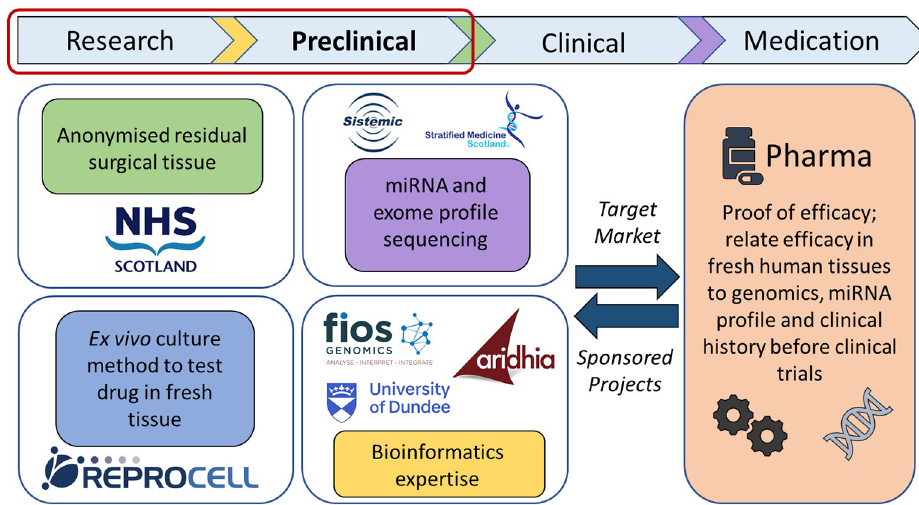
Fig 1. Diagram describing the interaction between each collaborator and the different data